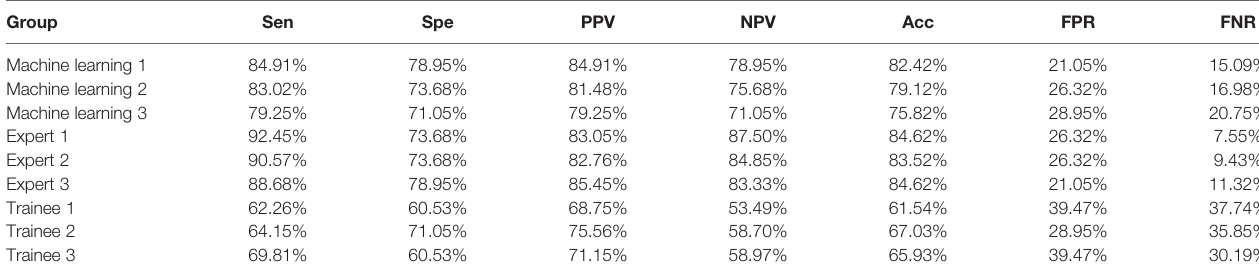
TABLE 3 | Diagnostic ef fi ciency of the three groups by qualitative grading score. Group